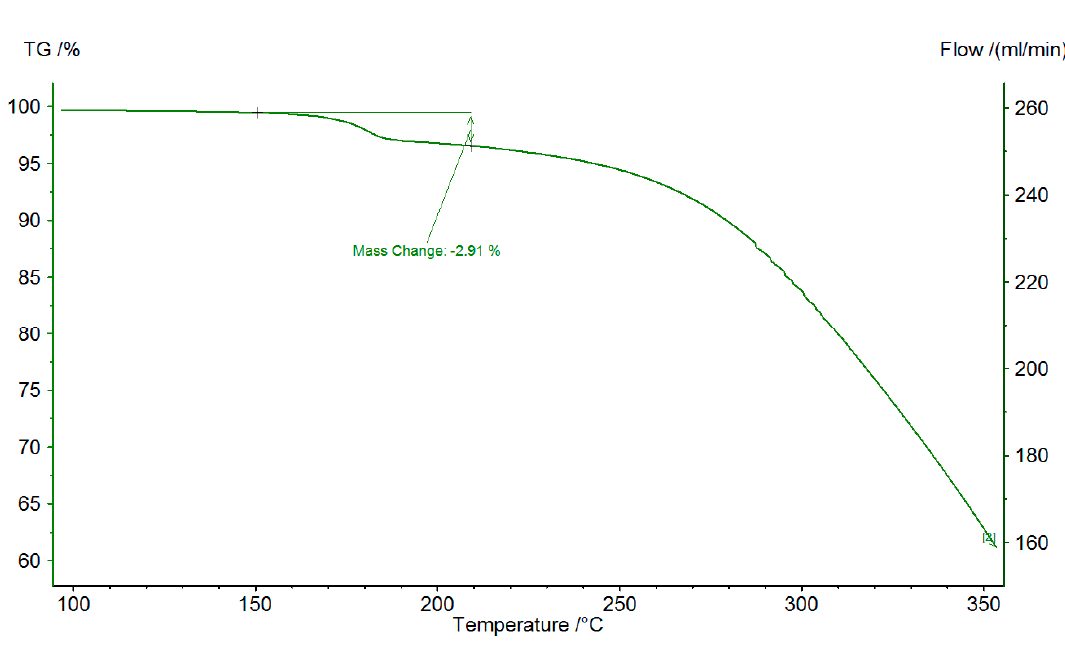
Figure 2. TG analysis of i Bu 7 SSQ-3OH showing initial mass loss (cropped for visibility).